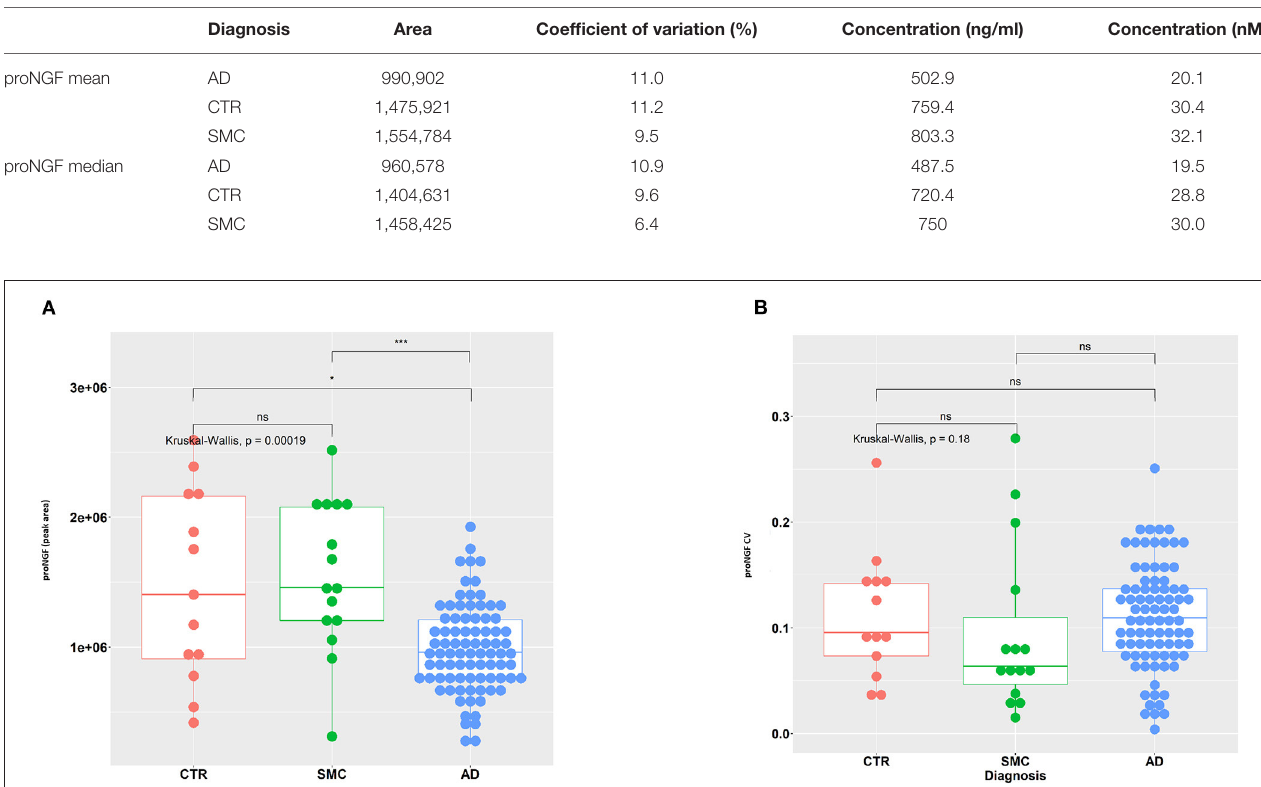
for patients with AD. This will require the comparison of